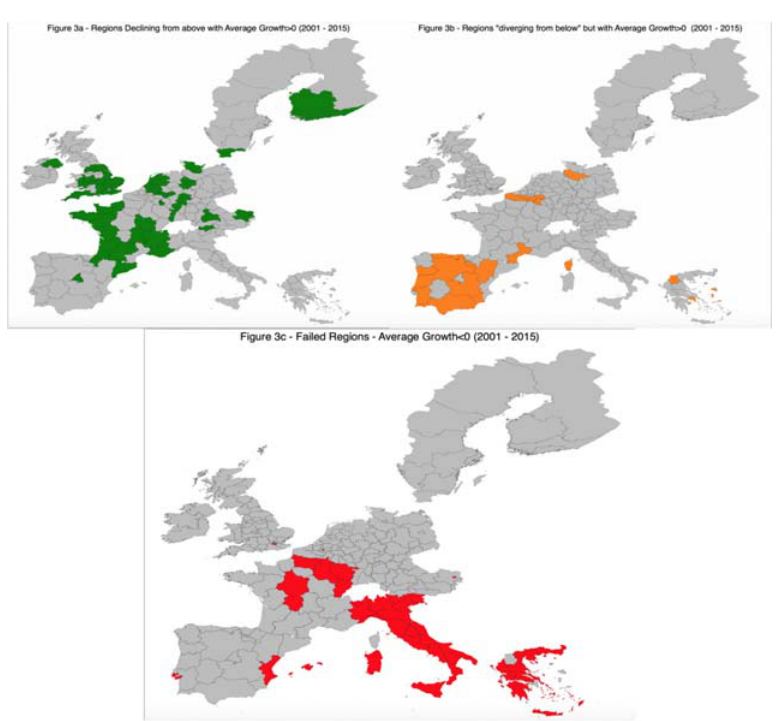
Figure 3 . European regions by